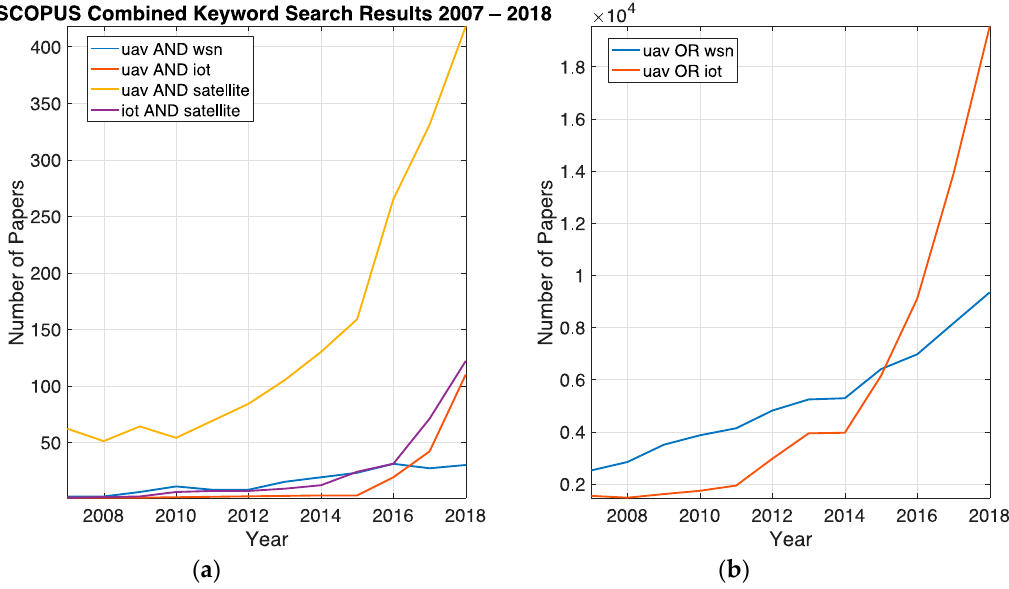
Figure 4. SCOPUS search results on keywords between 2007 and 2018: ( a ) UAV and WSN, together, and UAV and IoT, together and ( b ) UAV or WSN, UAV or IoT.